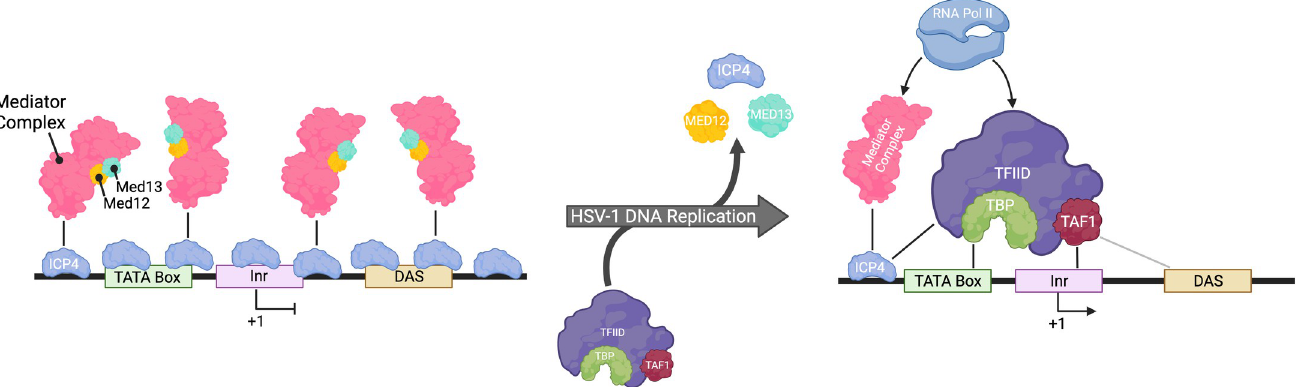
Fig 2. Model of HSV-1 γ 2 gene promoter interactions before and after DNA replication. HSV-1 γ 2 promoter regions contain a TATA box, Inr element, and DAS. The TATA box is within the –34 to –24 region in the promoter depending on the gene. The Inr flanks the +1 site and the DAS is in the 5 0 untranslated region. Prior to DNA replication, ICP4 coats γ 2 genes in a sequence-independent manner. ICP4 recruits the Mediator complex containing Med12 and Med13, which are members of the Mediator kinase domain that can inhibit transcription. Following the onset of DNA replication, ICP4 binding to γ 2 genes decreases. This may expose the promoter, enabling ICP4 to recruit TFIID containing TBP and TAF1 to the promoter region. It is possible that loss of the Mediator kinase domain following replication licenses γ 2 transcription. Collectively, Mediator and TFIID may recruit Pol II to γ 2 genes. Note that this is a proposed model based on current data and other factors likely play a role in this process. Figure created using www.biorender.com. DAS, downstream activation sequence; HSV-1, herpes simplex virus type-1, hpi, hours post infection; Pol II, RNA polymerase II; TBP, TATA binding